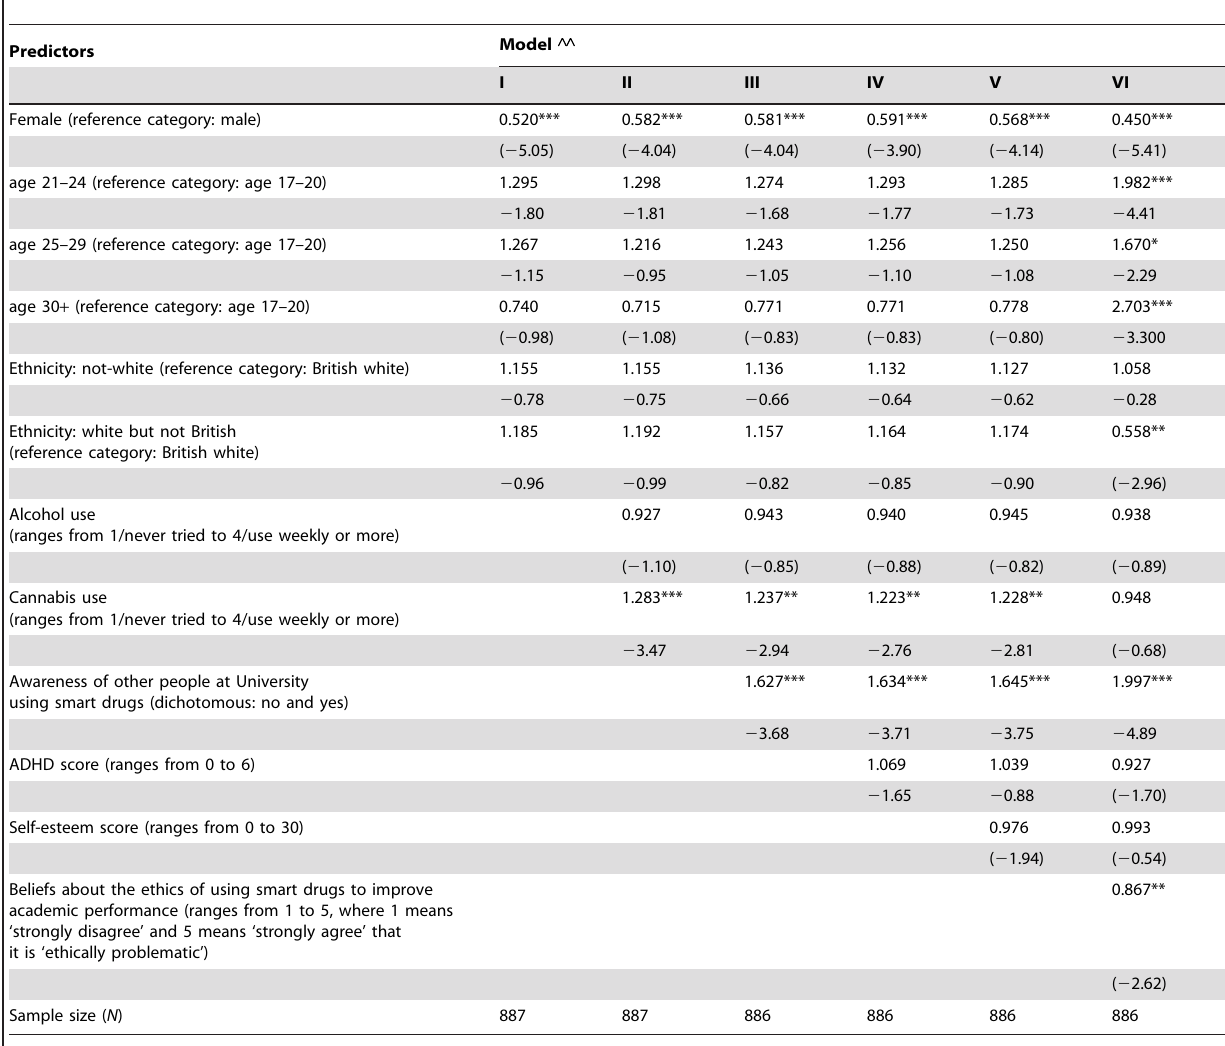
Table 12. Ordinal logistic regression predicting knowledge and use of Adderall. +